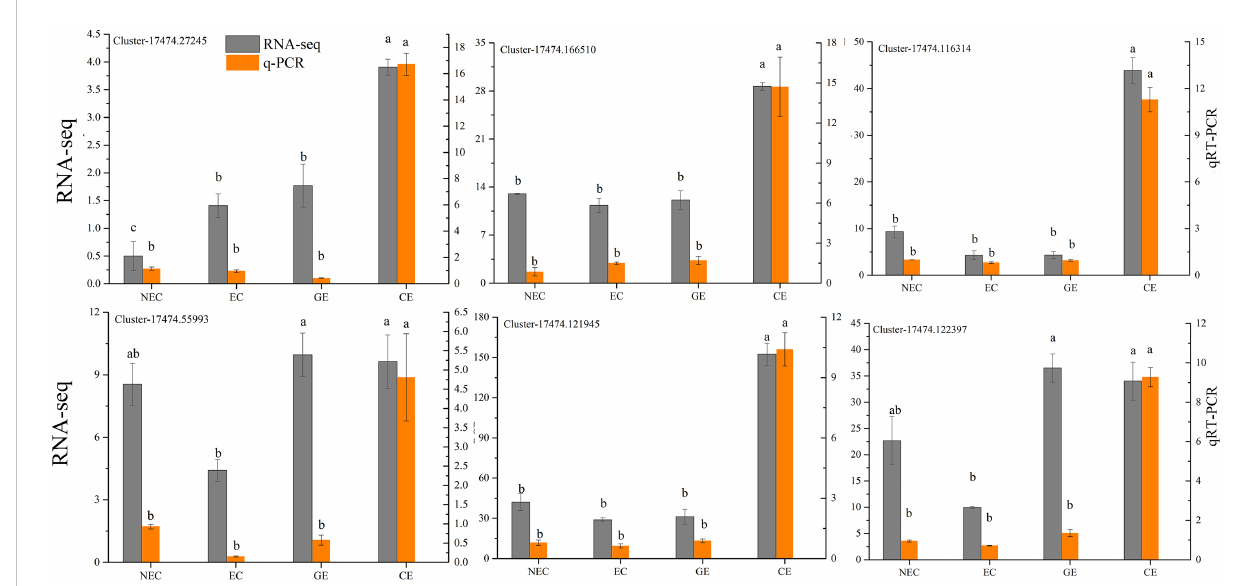
FIGURE 3 Analysis of the RNA-Seq and qRT − PCR data for the 6 genes. The different lowercase letters are signi fi cantly different using the Tukey ’ s test (P< 0.05).